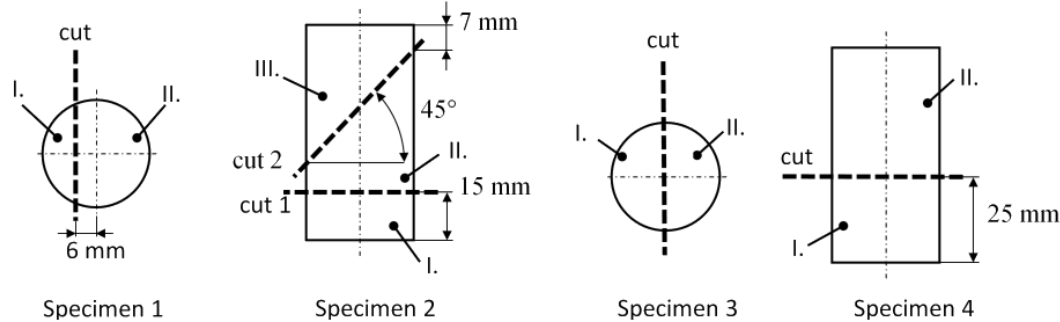
Figure 4. Cut-up plan for cylindrical specimens.